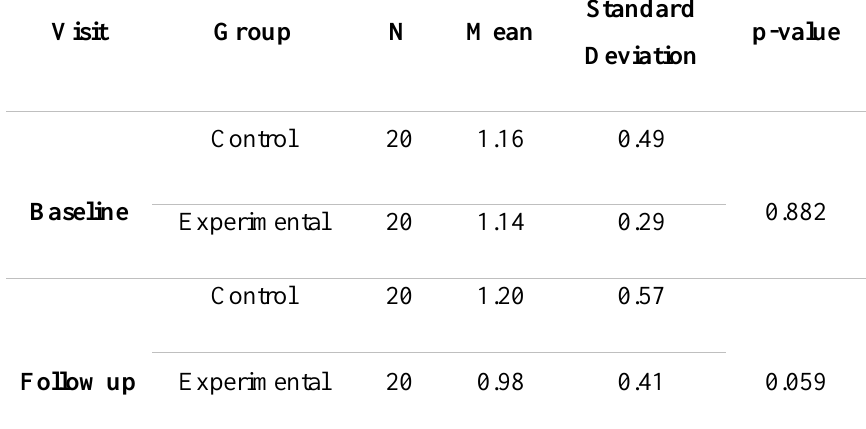
Table 1. Comparison of Mean Plaque Scores between Control and Experimental